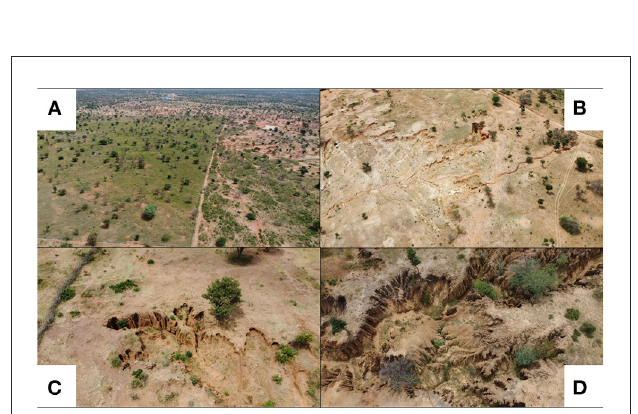
FIGURE2 Images showing the high erodibility of Arenic Lixisol soils in the study area. (A) A range land undergoing degradation. (B) A sample section of degraded land with visible rill channels. (C) Growing gullies. (D) Severely degraded sections with deep and wide